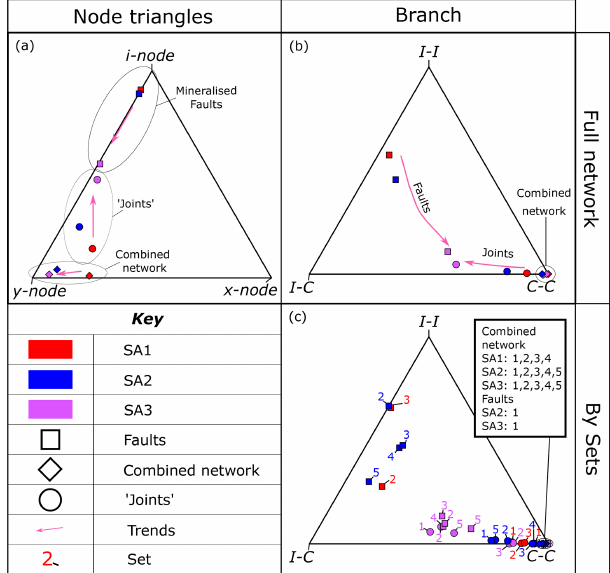
Figure 9. Network topology data. Node and branch triangle (fol- lowing Sanderson and Nixon, 2015) for the joint, fault, and com- bined fracture networks for the three sample areas shown in Fig. 8: (a) node and (b) branch data presented by sample area for the fault, joint, and combined networks, and (c) branch data by set, as out- lined in S2, to investigate the directionality of network connectivity. Please see the main text for a description of the main